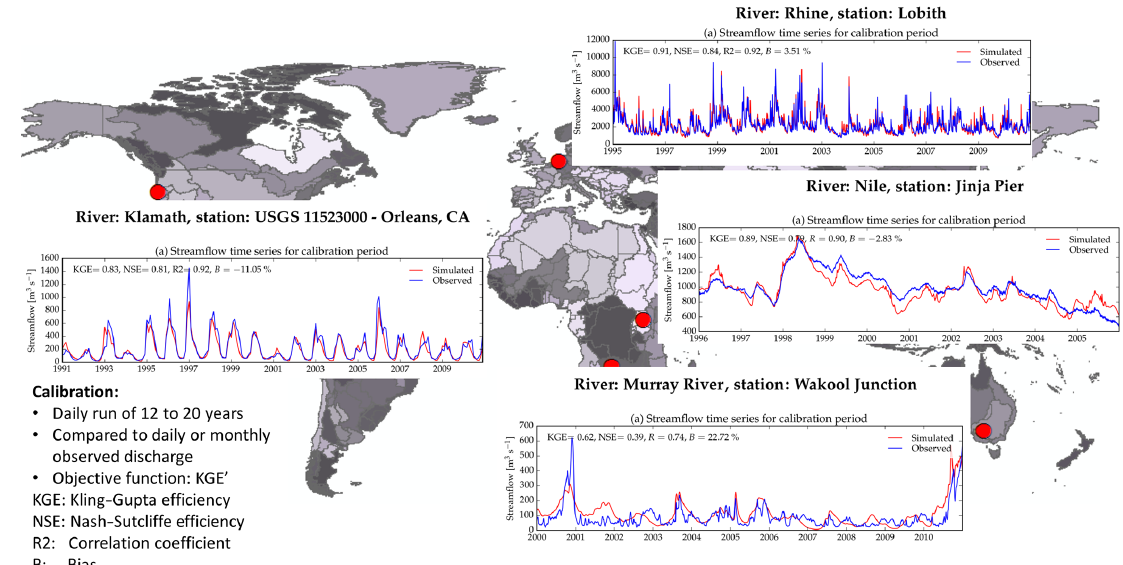
Figure 5. Calibration results for some chosen stations